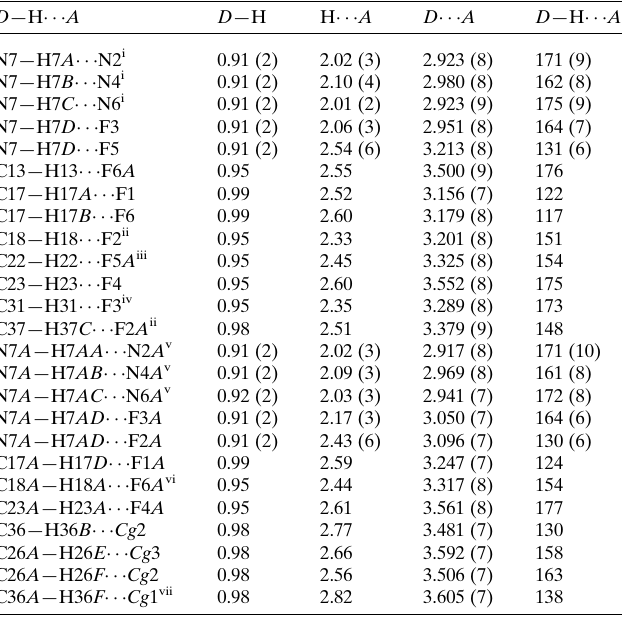
Table 2 Experimental details. Crystal data Chemical formula